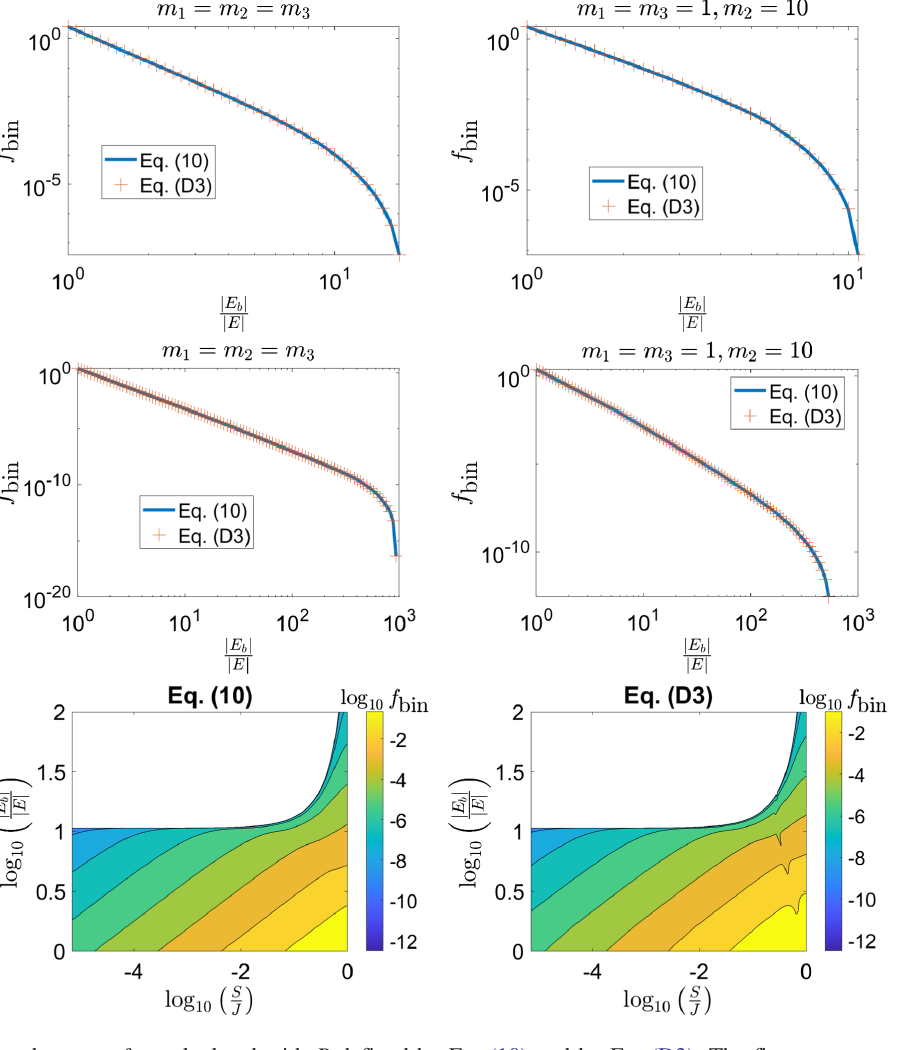
FIG. 10. Comparison between f calculated with R defined by Eq. (10) and by Eq. (D3). The first two rows show the marginal bin energy distribution, and the last line shows that joint energy-spin distribution [left is for Eq. (10); right is for Eq. (D3)]. The top row displays f for a large value of J , while the second is for a low value. For the bottom row, we use the same value of J as for the top row, bin and equal masses. All rows have β ¼ 1 . 5